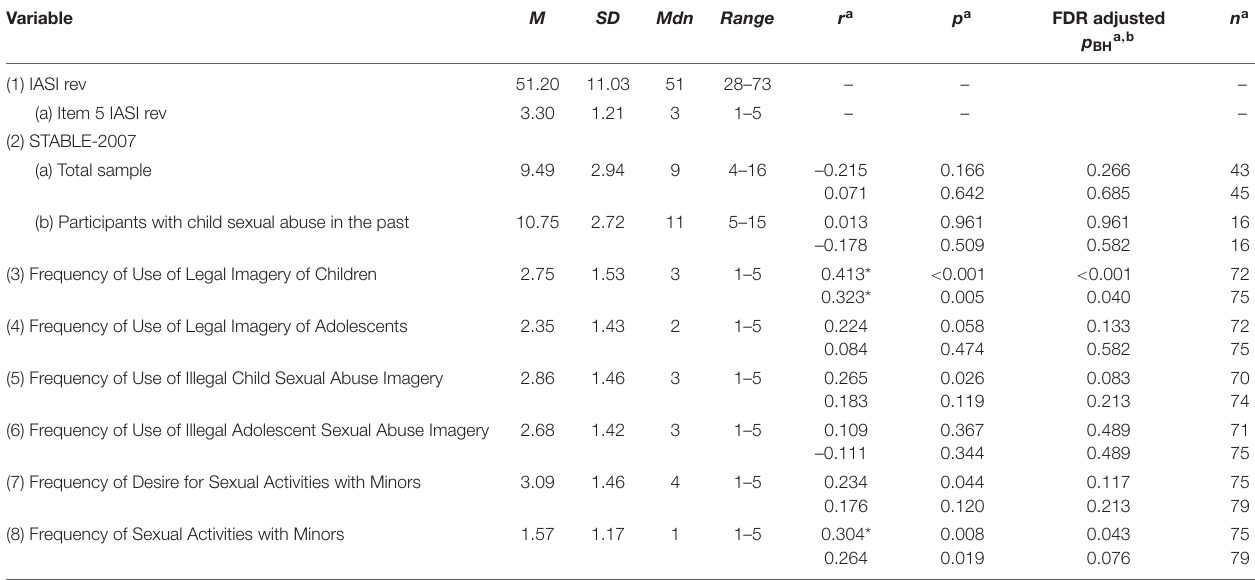
TABLE 3 | Descriptive statistics and correlations between IASI rev (Item 5 IASI rev) and STABLE-2007, Frequency of Use of Legal Imagery of Children, Frequency of Use of Legal Imagery of Adolescents, Frequency of Use of Illegal Child Sexual Abuse Imagery, Frequency of Use of Illegal Adolescent Sexual Abuse Imagery, Frequency of Desire for Sexual Activities with Minors, and Frequency of Sexual Activities with Minors.